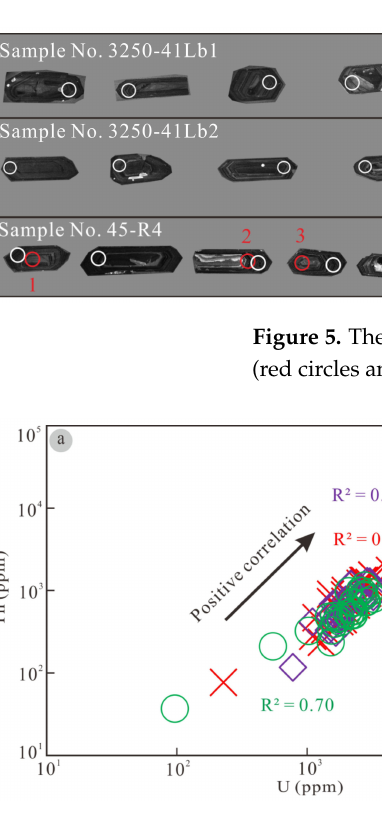
Figure 6. The zircon Th vs. U and Pb vs. U from quartz diorite in the Yangla Cu-W polymetallic